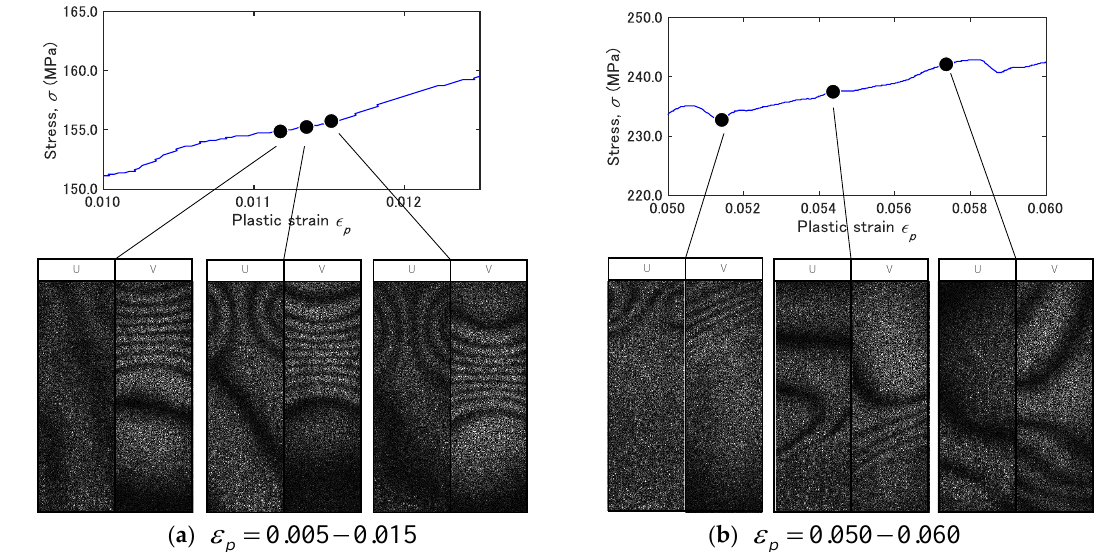
Figure 12. Shear band activity in 7075-annealed alloy observed in the strain range of ( a ) ε p = 0.005 − 0.015 and ( b ) ε p = 0.050 −